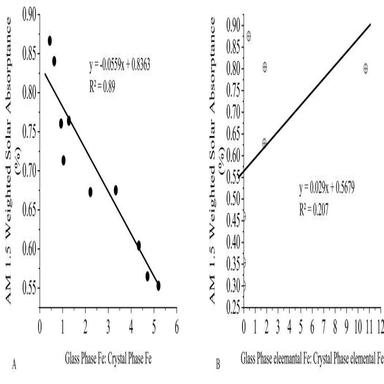
Ratio of glass phase elemental iron to crystal phase elemental iron in the as-received samples (A) and the thermally cycled samples (B).